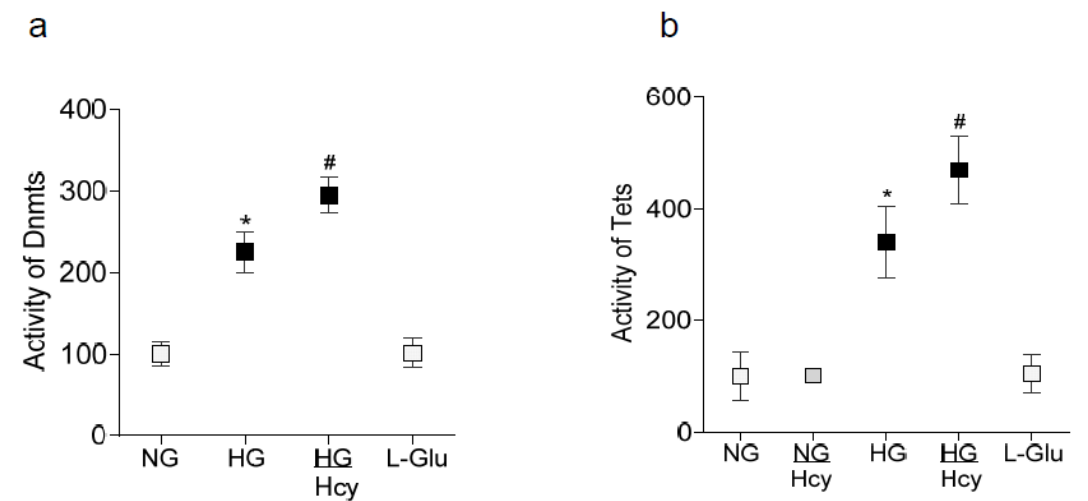
Figure 3. Effect of homocysteine on the activities of Dnmts and Tets. HRECs incubated in the presence or absence of homocysteine were analyzed for the activities of ( a ) Dnmts in 5 μ g nuclear protein using a DNA Methyltransferase Activity/Inhibition assay kit, and ( b ) Tets in 10–15 μ g nuclear protein using a TET Activity/Inhibition Assay Kit. The values obtained from cells in NG are considered 100%. Values are represented as the mean ± SD from four to five cell preparations, with each measurement made in duplicate. * and # p < 0.05 compared to NG and HG respectively.